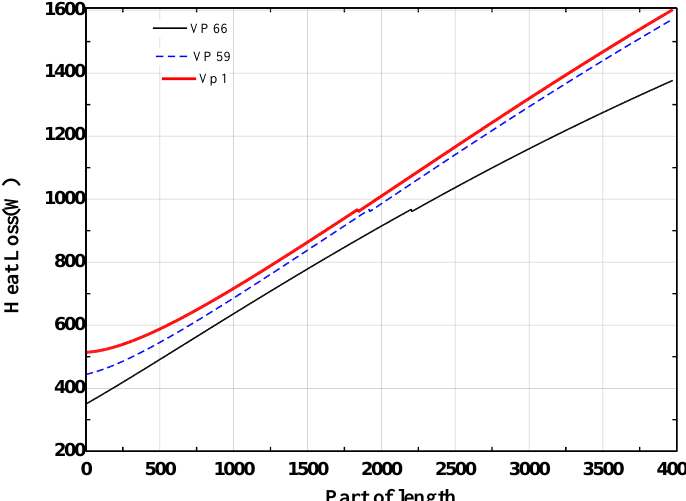
Figure 8. Total heat loss vs. pipe segments for different thermal